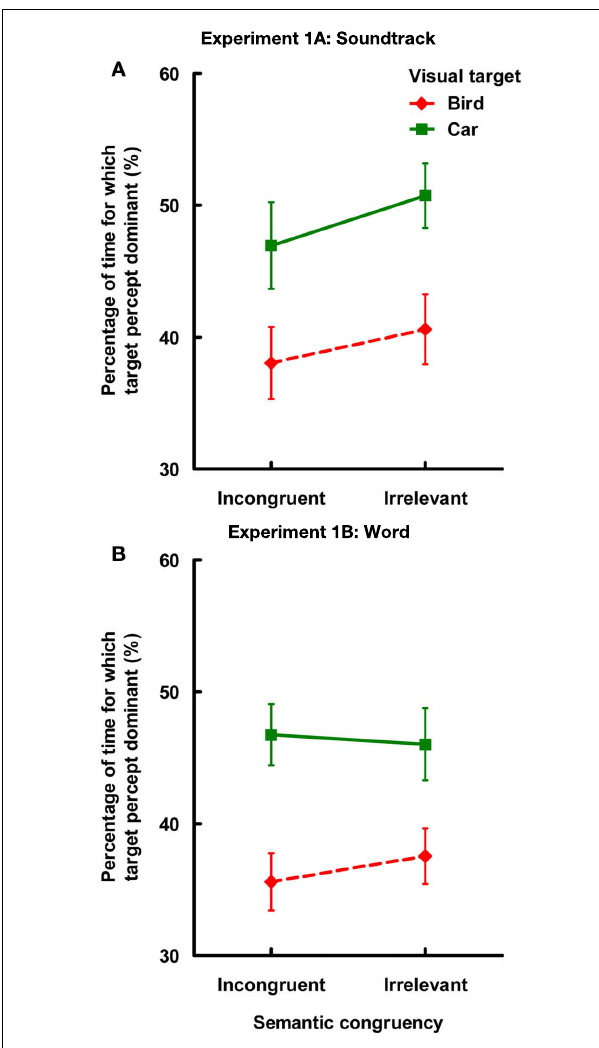
FIGURE 2 | Results of the proportion of time for which the target percept was dominant (either bird or car, proportion of the 60-s viewing period) in Experiments 1A and 1B [(A,B), respectively]. Error bars represent ± 1 SE of the mean.